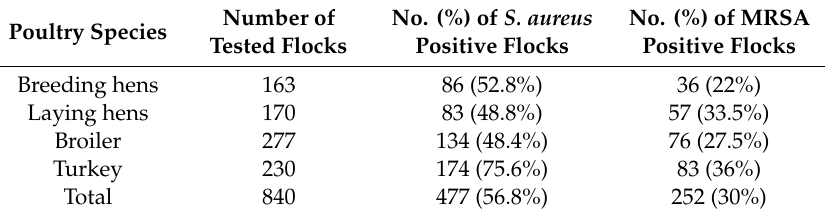
Table 1. The number of Staphylococcus aureus and Methicillin-resistant Staphylococcus aureus (MRSA) positive farms (flock prevalence) by poultry